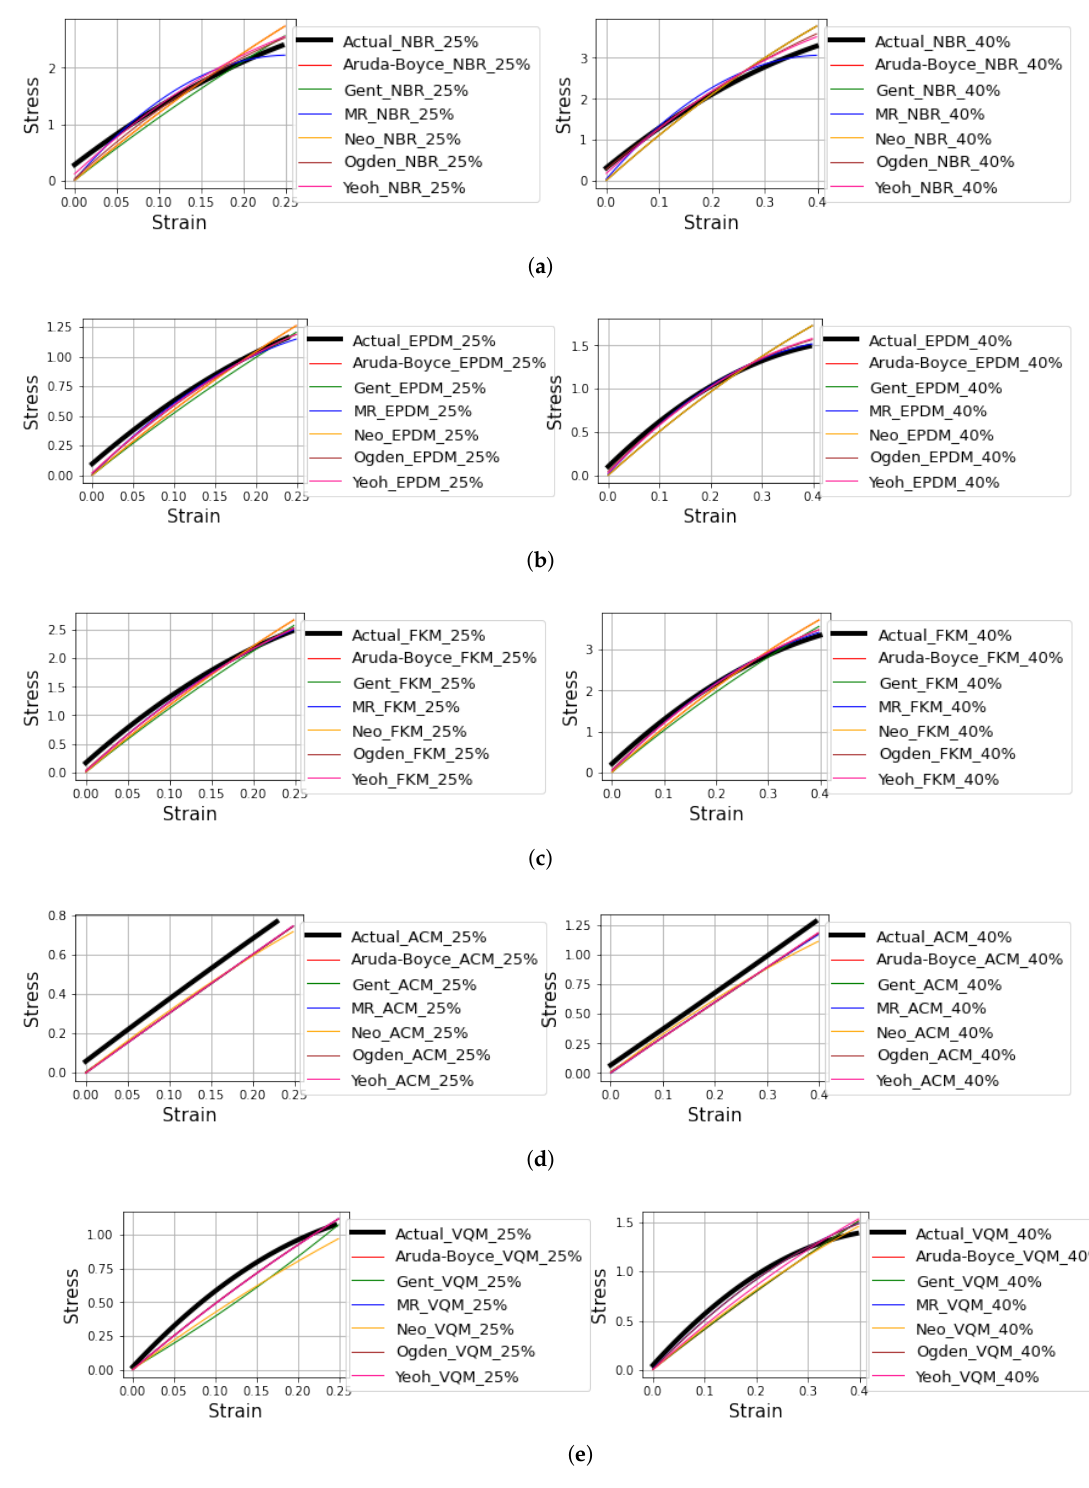
Figure 6. Curve fitting by quadratic regression model on the hyperelastic model outputs for the materials at 25% and 40% displacement ( a ) NBR, ( b ) EPDM, ( c ) FKM, ( d ) ACM, and ( e )